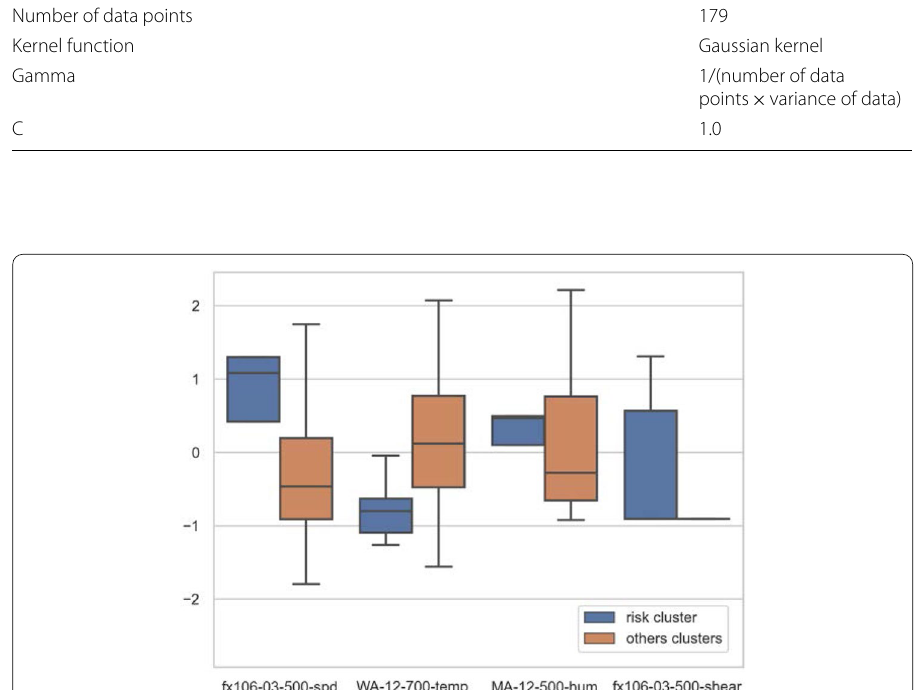
Fig. 9 Comparison of days with and without turbulence predicted for the 2019